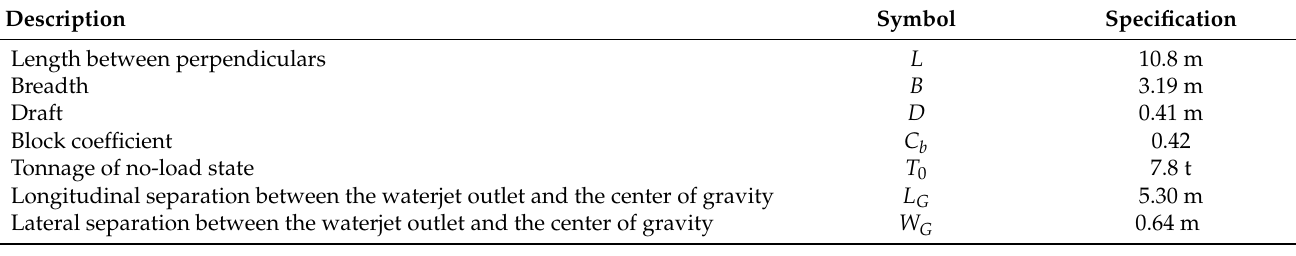
Table 2. Specifications of the twin-waterjet propelled vessel.